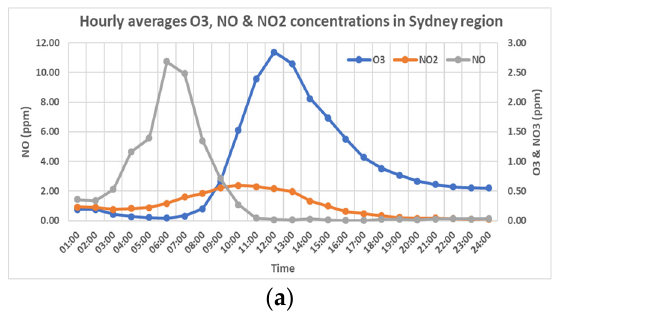
Figure 5. The EST hourly average ( a ) NO, NO 2 , O 3 , and ( b ) CO, and SO 2 concentrations measured at the air quality monitoring stations in Sydney region on 10 December 2019.